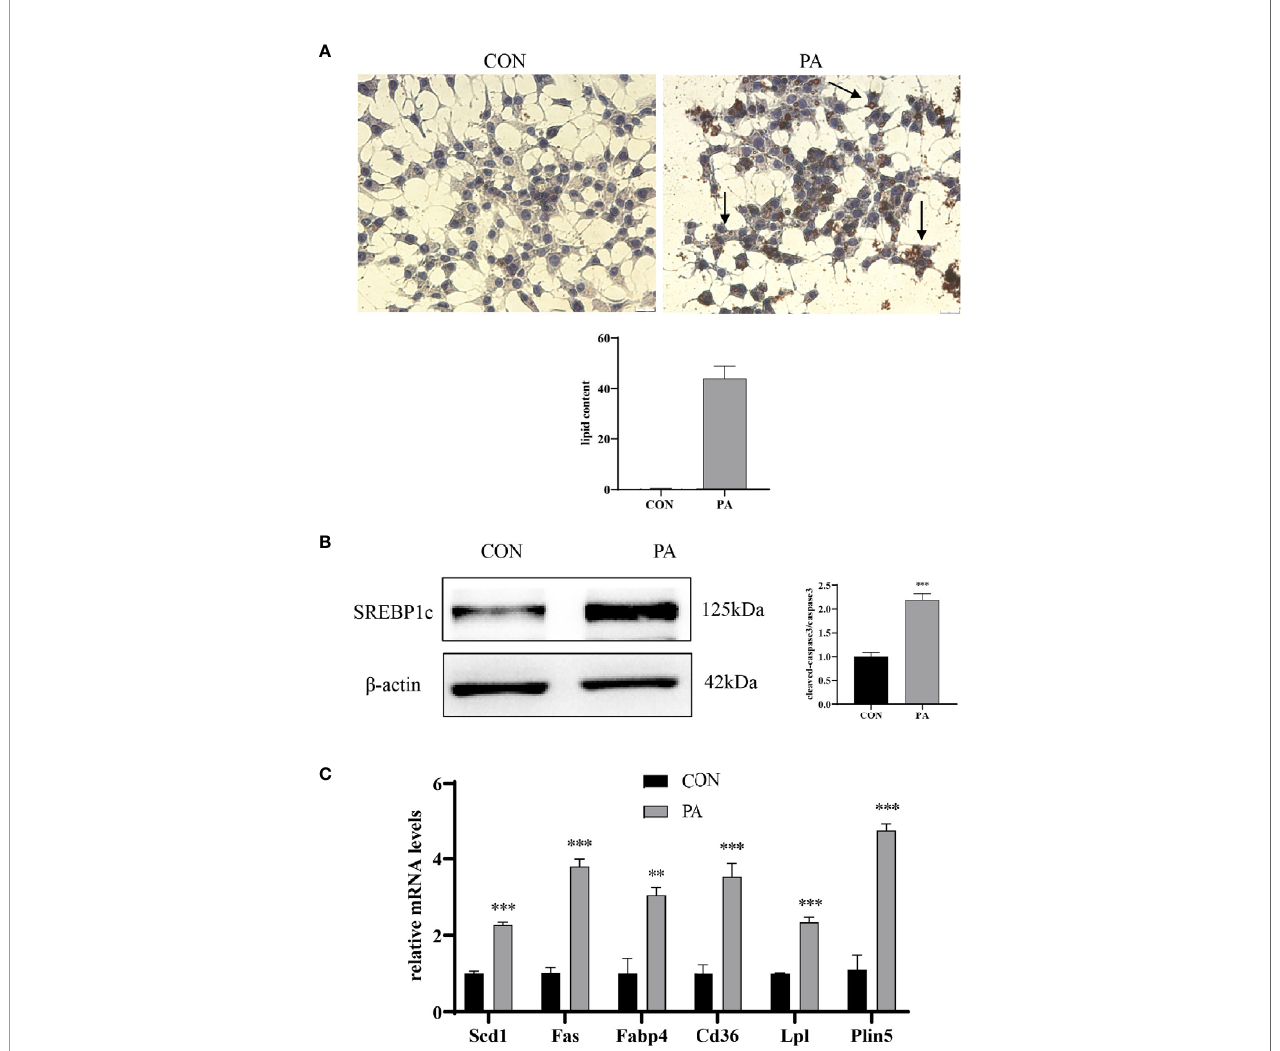
FIGURE 3 | PA induced lipid accumulation in INS-1 cells. (A) Oil red O staining was performed to detect the intracellular lipid accumulation, scale bar=20 m m. Quanti fi cation of lipid content was performed by ImageJ. (B) The protein expression of SREBP1c was detected by Western blot. (C) The mRNA levels of TG – synthesis, uptake, hydrolysis, and storage-related genes, including Fas, Scd1, Cd36, Fabp4, Lpl, and Plin5. Data are expressed as the mean ± SEM. **p < 0.01; ***p < 0.001 (compared with control